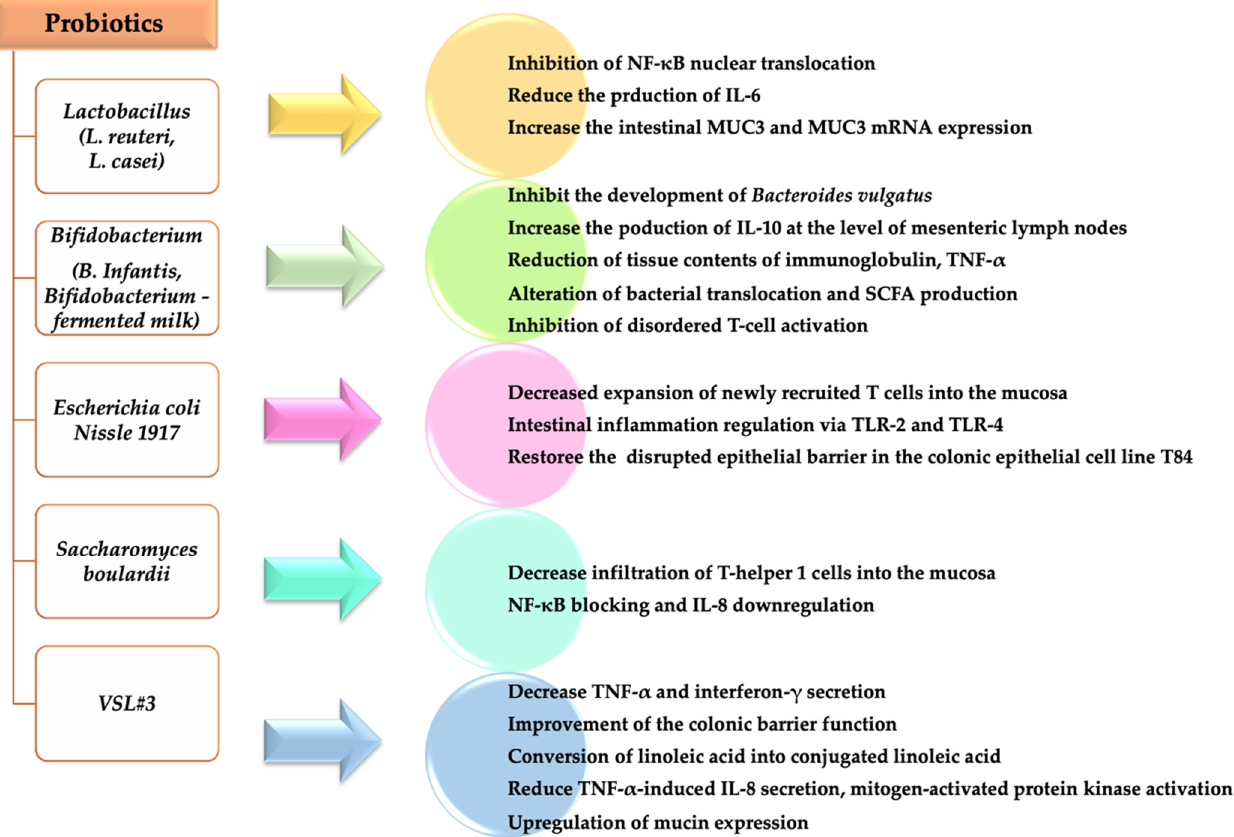
Figure 2. Effects of different probiotics in IBD. Table 1. Dose, duration of treatment, and efficiency of probiotic in ulcerative colitis and Crohn’s disease. Ulcerative Colitis Probiotic